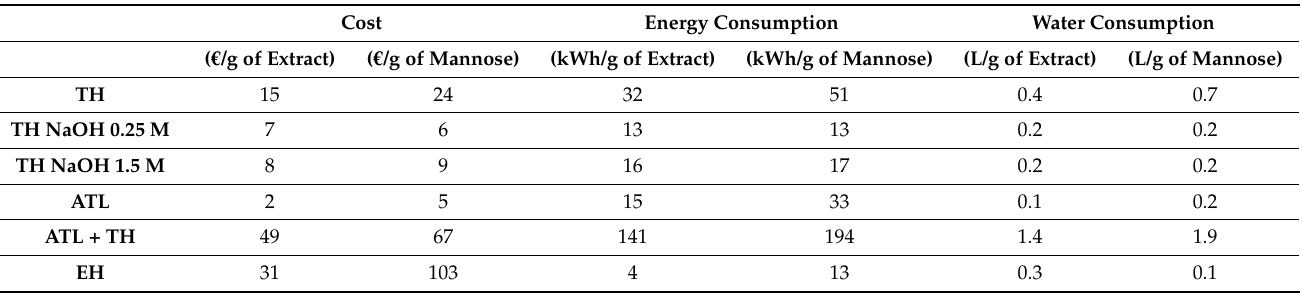
Table 4. Results of the Cost ( € ), Energy (kWh) and Water Consumption (L) per gram of extract and per gram of mannose of each mannans extract